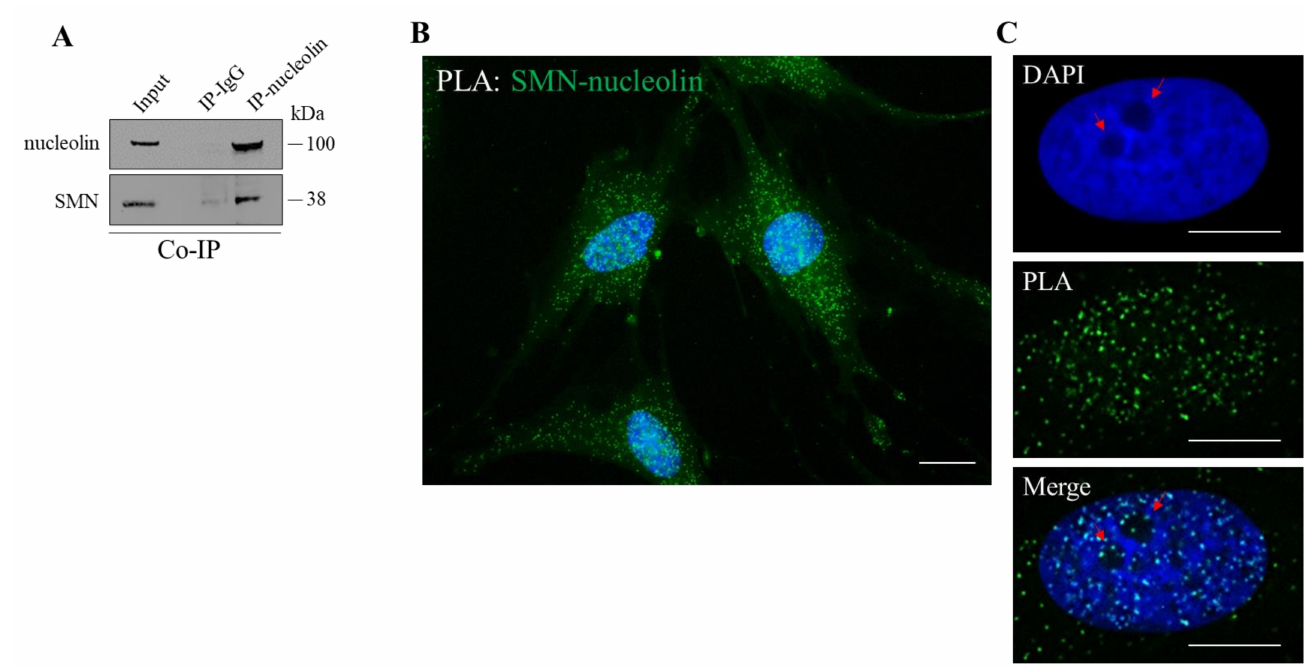
Figure 1. SMN interacts with nucleolin. ( A ) Cellular extracts from hTert-Fibroblasts were processed for co- immunoprecipitation assay (Co-IP) using nucleolin monoclonal antibody-conjugated beads (nucleolin Ab) or mouse IgG-conjugated beads (IgG), as negative control. Then, samples were subjected to Western Blot analysis. The 5% of the protein extract was used as input. Representative immunoblotting, of n = 3 independent experiments showing the co-precipitation of SMN with nucleolin. ( B ) Representative image of in situ proximity ligation assay (PLA) performed in hTert-Fibroblasts using primary antibodies against SMN and nucleolin (rabbit polyclonal Ab and mouse monoclonal Ab, respectively). PLA puncta (green dots) are indicative of SMN-nucleolin interaction sites. Nuclei were stained with DAPI (blue). Scale bar 10 µ m. ( C ). In detail, a representative nucleus labelled with DAPI. Nucleoli are typically visible as dark regions due to low DNA density (red arrows). As showed in the Merge panel, some PLA dots are visible around and within the nucleoli. Scale bars, 5 µ